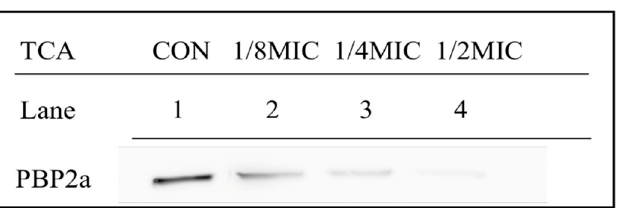
Figure 3. Effect of TCA at sub-concentrations on the expression of penicillin-binding protein 2a (PBP2a) in MRSA (ATCC 33591). Lane 1, the control was treated without TCA; Lane 2-4, PBP2a production after treatment with TCA at 1/8 MIC, 1/4 MIC, and 1/2 MIC, respectively.